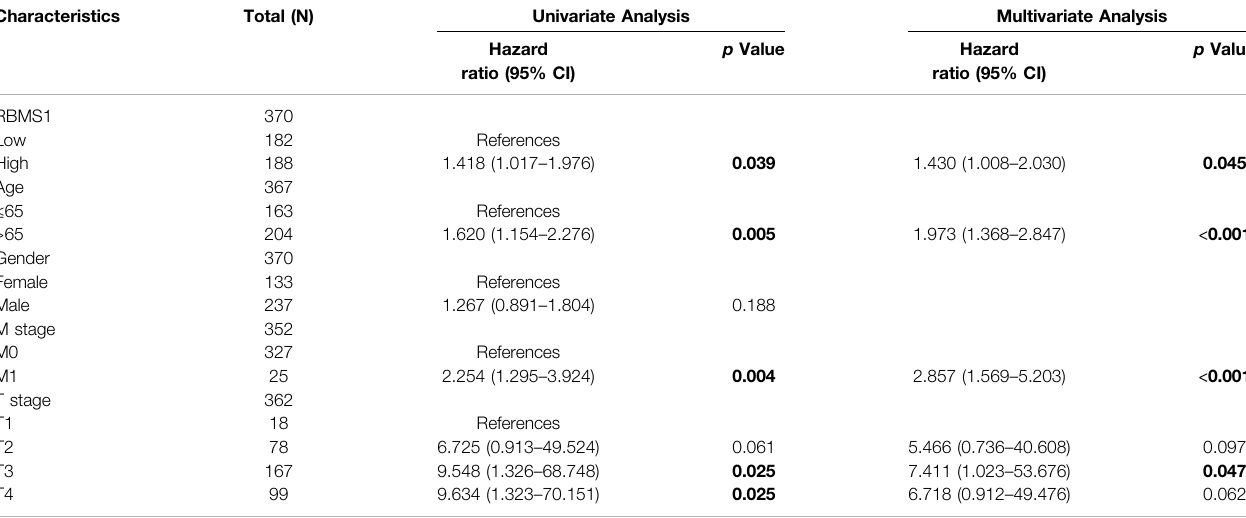
TABLE 1 | Univariate and multivariate Cox analysis of clinical variables and RBMS1.